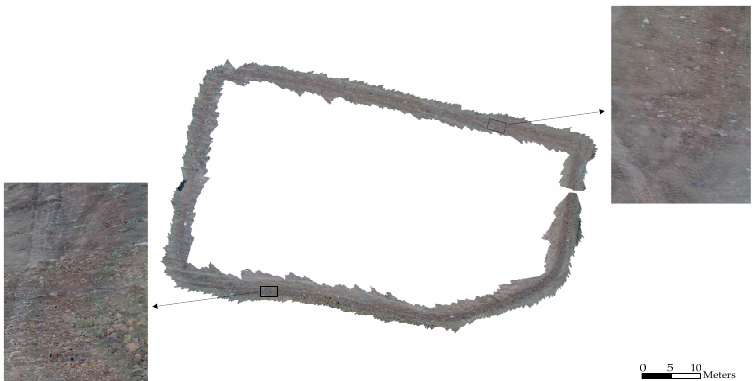
Figure 9. Overhead view of the mapping result of the whole scene in experiment II using our method. The two insets are detailed 3D views of the areas in the two rectangles.